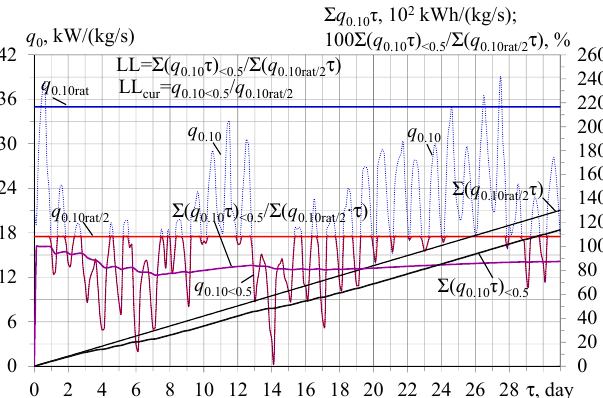
Figure 5. Actual values of thermal load q 0.10 when cooling the air to 10 ◦ C; relative values q 0.10 ˂ 0.5 / q 0.10rat/2 of current refrigeration capacity q 0.10 ˂ 0.5 referring to q 0.10rat /2; relative values of monthly summarized refrigeration energy consumed ∑ ( q 0.10 ˂ 0.5 τ )/ ∑ ( q 0.10rat/2 τ ) referring to refrigeration energy generated ∑ ( q 0.10rat/2 τ ) according to the design value q 0.10rat /2: LL cur = q 0.10 ˂ 0.5 / q 0.10rat/2 ; LL = ∑ ( q 0.10 ˂ 0.5 τ )/ ∑ ( q 0.10rat/2 τ ).